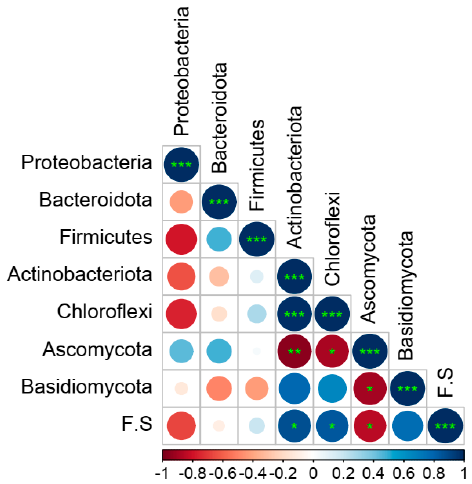
Figure 4. Heatmap of the correlation analysis between the application amount of GLR organic fertilizer and the dominant phyla of bacteria and fungi. Note: F. S − addition amount of GLR organic fertilizer; Pearson analysis * ( p < 0.05), ** ( p < 0.01), *** ( p < 0.001). Positive correlation is displayed in blue, and negative correlation is displayed in red. The color intensity and the size of the circle are proportional to the correlation coefficient.